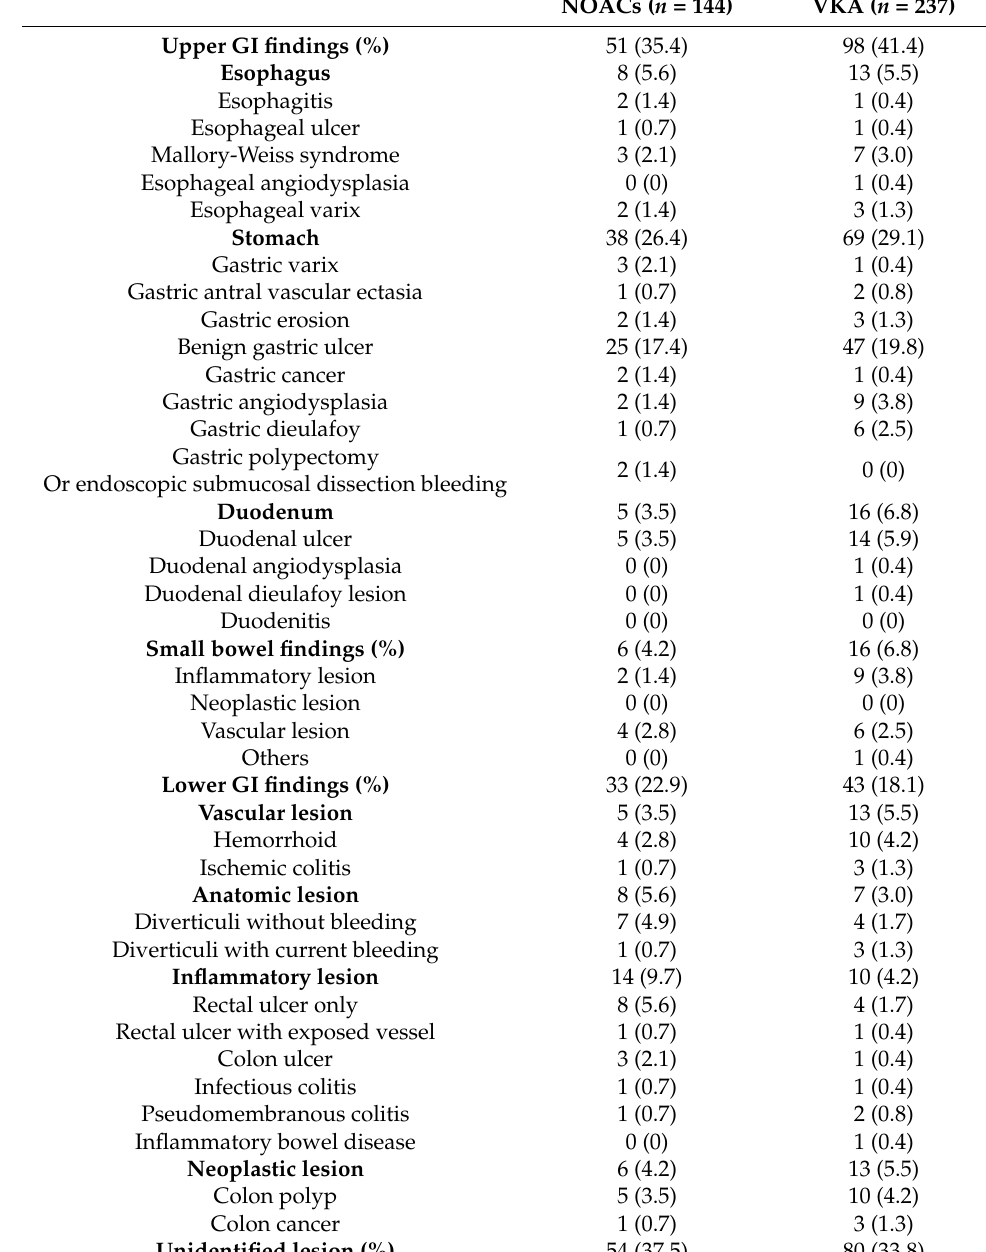
Table 2. Sources of GI bleeding in patients with NOACs or